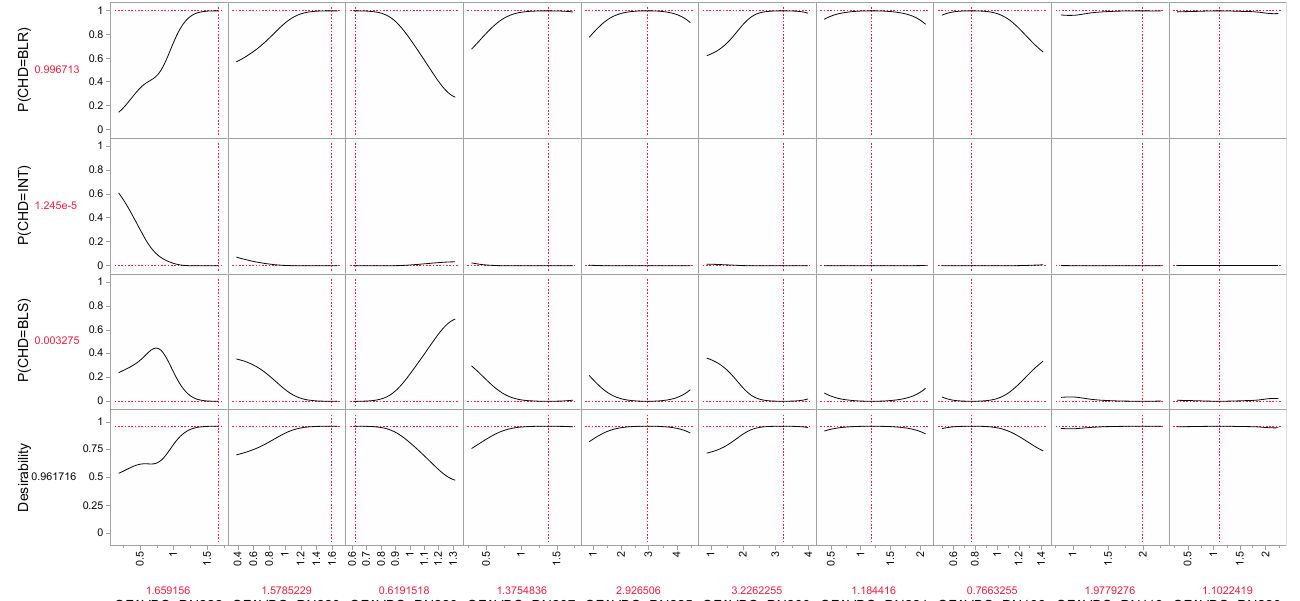
Figure 5. Desirability analysis based on the neural network “CHD-field (cid:212) CHD-field(e)” (Table 5). The “P” before the terms on the y-axes refers to the probability, and the protein concentration levels associated with a 99.7% chance of a coral being bleaching-resistant (BLR) are shown. The desirability approached the target value of 1 since there was <1% chance of a coral demonstrating these protein concentrations either being intermediately bleaching-susceptible (INT) or fully bleaching-susceptible (BLS). Only the top 10 most influential proteins of all 28 used in the model have been shown (ordered from most influential on the left to least on the right); values in red above protein accession numbers represent the target levels (raw iTRAQ values) that resulted in maximum desirability.